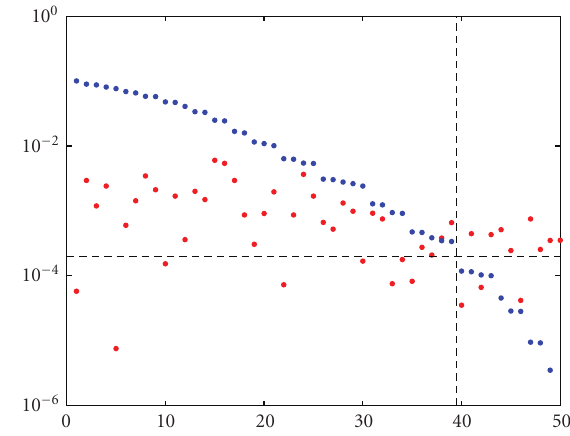
Figure 2: Singular values (blue) and singular components (red) of the right-hand